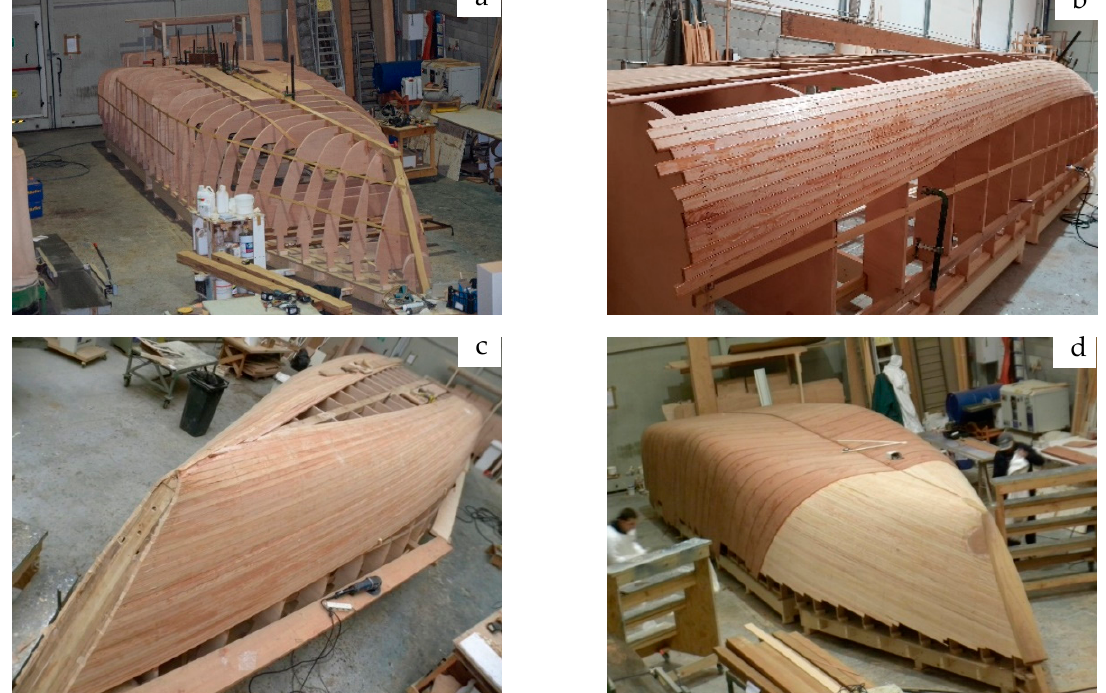
Figure 1. Phases of the construction of a strip-planked hull.